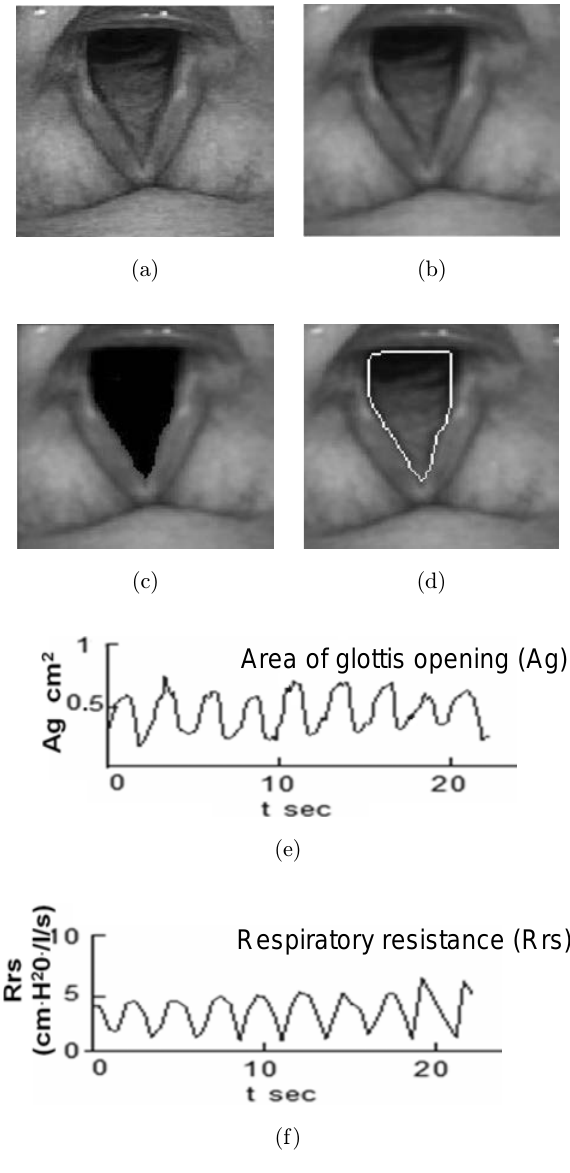
Fig. 3. Area of glottis opening and its °uctuation with time as measured bythe image-based method. (a) Grayscale image ofthe glottis, which was obtained by converting the original RDB image captured by the CCD camera of the nasopharyngoscope. (b) (cid:1) (d) Images resulted from Gaussian smooth ¯ltering, pixel segmentation, and Canny edge detection, respectively, of the grayscale image of the glottis. These image processing algorithms together identi¯ed the edge of the glottis aperture (outlined by the white line in (d)), from which the area of glottis opening ( A g Þ was computed. (e),(f) The time course of °uctuation of glottis opening ( A g Þ , and the respiratory resistance ( R rs ),